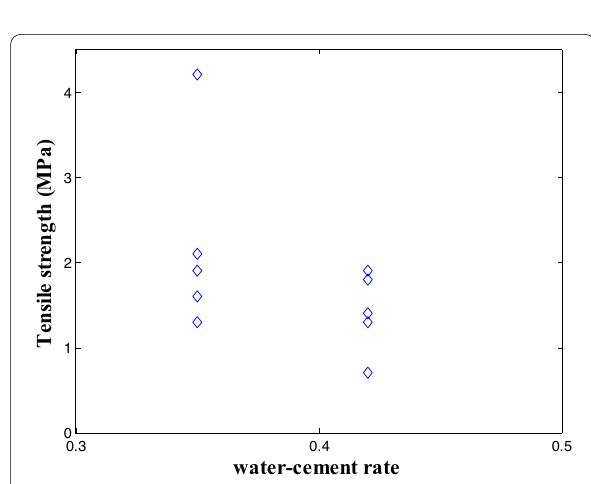
0.3 Fig. 8 Impact of the water–cement rate on the tensile strength of the Stratabinder HS cement.